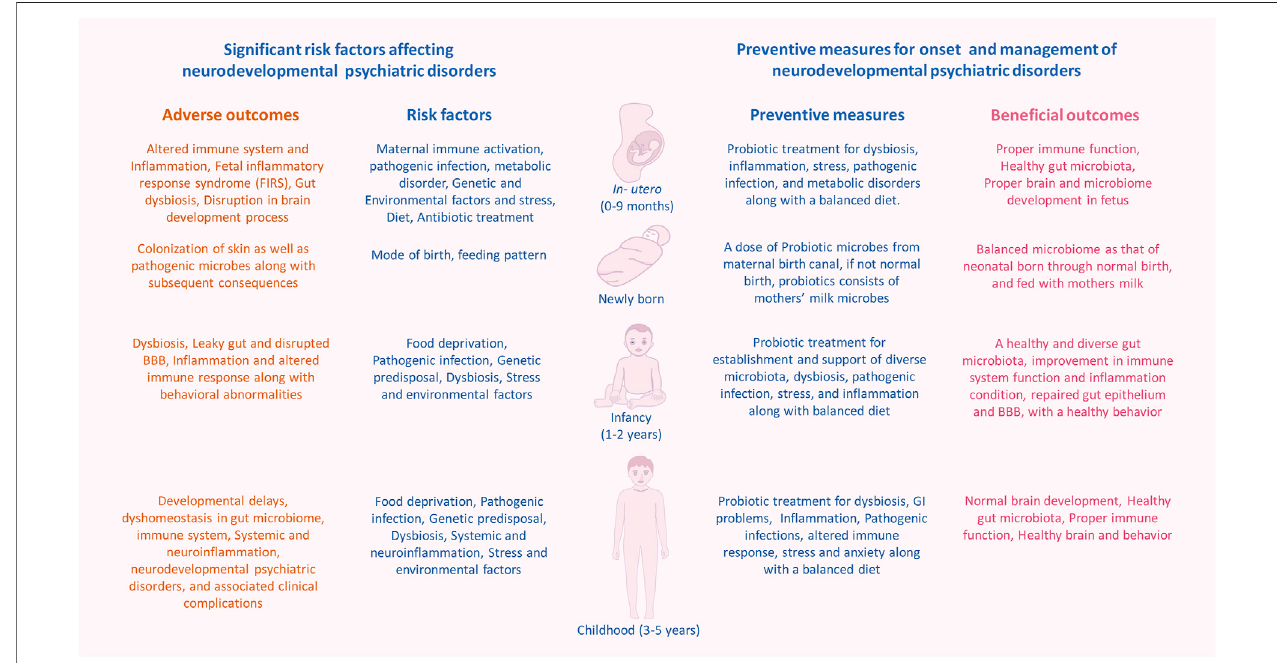
FIGURE 5 | Probiotic therapy to overcome adverse effects NDDs at developmental time points. Probiotic treatment at speci fi c time points such as in-utero , after immediate birth, infancy and childhood may help and support the establishment of stable and healthy gut microbiota, prevent the dysregulation in the developmental process, and play the role of a crucial preventive measure for the onset of neurodevelopmental and psychotic disorders via neutralizing the effects of inducing factors.